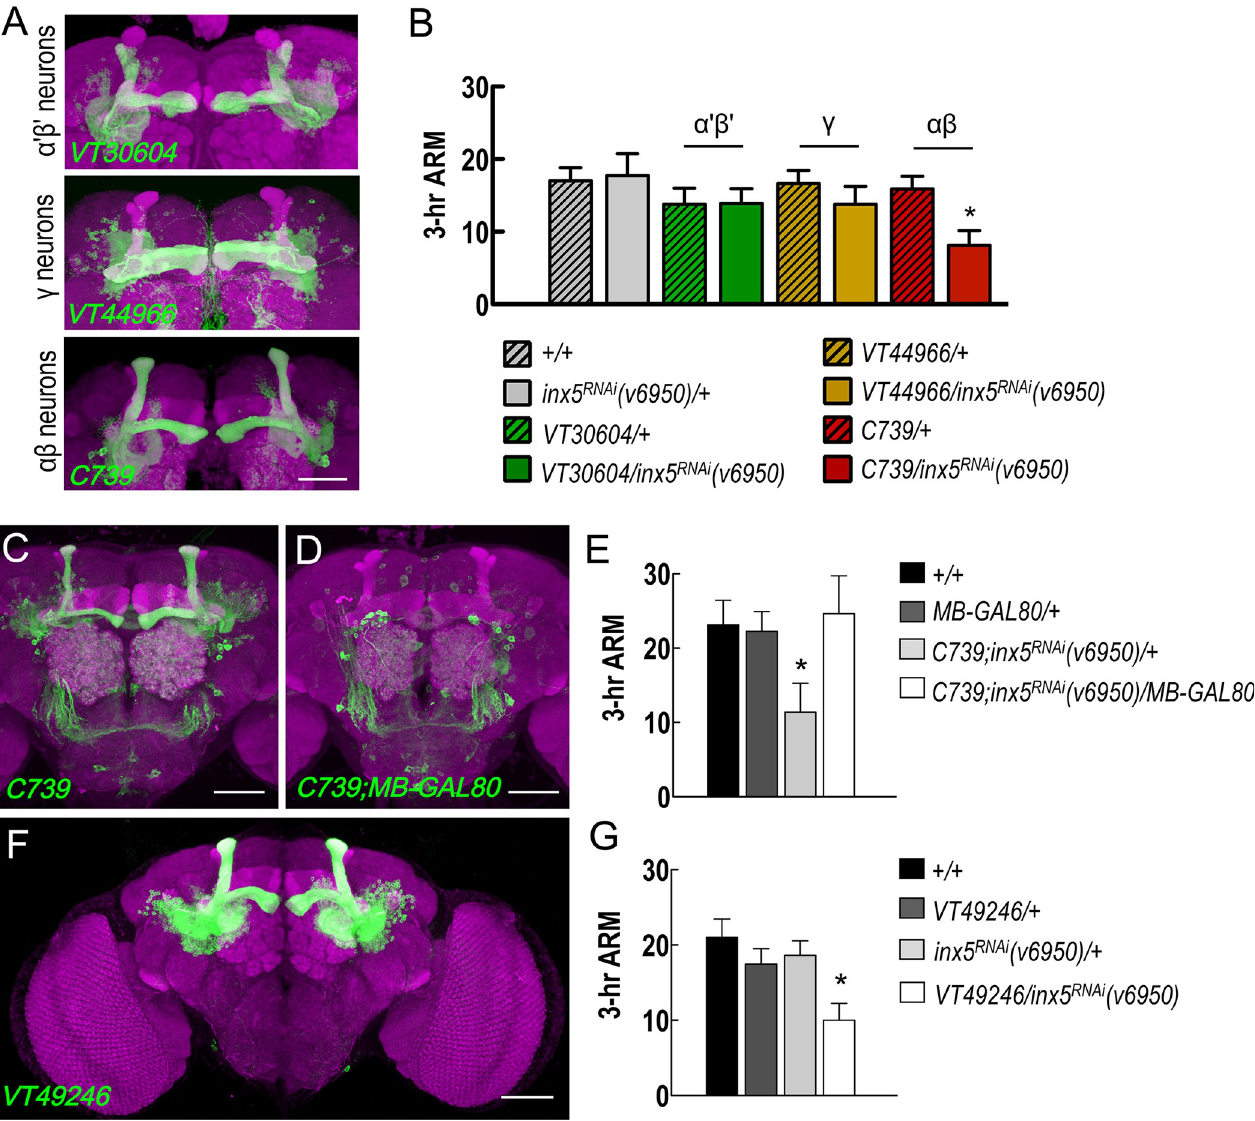
Fig 3. INX5 specifically acts on αβ neurons during ARM formation. (A) Expression patterns (green) of VT30604-GAL4 ( α 0 β 0 neurons), VT44966-GAL4 ( γ neurons), and C739-GAL4 ( αβ neurons). The brain structures were counterstained with a DLG antibody (magenta). The scale bars represent 50 μ m. (B) VT30604-GAL4 , VT44966-GAL4 , and C739-GAL4 were used to drive UAS-inx5 RNAi expression in MB α 0 β 0 , γ , or αβ neurons, respectively. The 3-hour ARM values for these flies, including controls, are shown. Each value represents the mean ± SEM (n = 8). � , p < 0.05; one-way analysis of variance (ANOVA) followed by Tukey’s test. The genotypes were as follows: (1) +/+; +/+ , (2) +/+; UAS-inx5 RNAi (v6950)/+ , (3) +/+; VT30604-GAL4/+ , (4) +/+; VT30604-GAL4/ UAS-inx5 RNAi (v6950) , (5) +/+; VT44966-GAL4/+ , (6) +/+; VT44966-GAL4/UAS-inx5 RNAi (v6950) , (7) C739-GAL4/+; +/+ , and (8) C739-GAL4/+; +/UAS- inx5 RNAi (v6950) . (C) The expression pattern of C739-GAL4- driven GFP expression in the central brain. The brain structures were counterstained with a DLG antibody (magenta). The scale bar represents 50 μ m. (D) C739-GAL4- driven GFP expression in αβ neurons was reduced using the MB-GAL80 transgene. The brain structures were counterstained with a DLG antibody (magenta). The scale bar represents 50 μ m. (E) ARM defect in the C739;inx5 RNAi (v6950)/+ flies was rescued by removing the expression of GAL4 in αβ neurons using the MB-GAL80 transgene. Each value represents the mean ± SEM (n = 8) � , p < 0.05; ANOVA followed by Tukey’s test. The genotypes were as follows: (1) +/+; +/+ , (2) MB-GAL80/+; +/+ , (3) C739-GAL4/+; UAS-inx5 RNAi (v6950)/+ , and (4) C739-GAL4/MB-GAL80; +/UAS-inx5 RNAi (v6950) . (F) Expression pattern of VT49246-GAL4 ( αβ neurons). The brain structures were counterstained with a DLG antibody (magenta). The scale bars represent 50 μ m. (G) VT49246-GAL4 was used to drive UAS-inx5 RNAi (v6950) to confirm the requirement for INX5 in MB αβ neurons for 3-hour ARM formation. Each value represents the mean ± SEM (n = 13–14). � , p < 0.05; ANOVA followed by Tukey’s test. The genotypes were as follows: (1) +/+; +/+ , (2) +/+; VT49246-GAL4/+ , (3) +/+; UAS-inx5 RNAi (v6950)/+ , and (4) +/+; VT49246-GAL4/UAS-inx5 RNAi (v6950) .